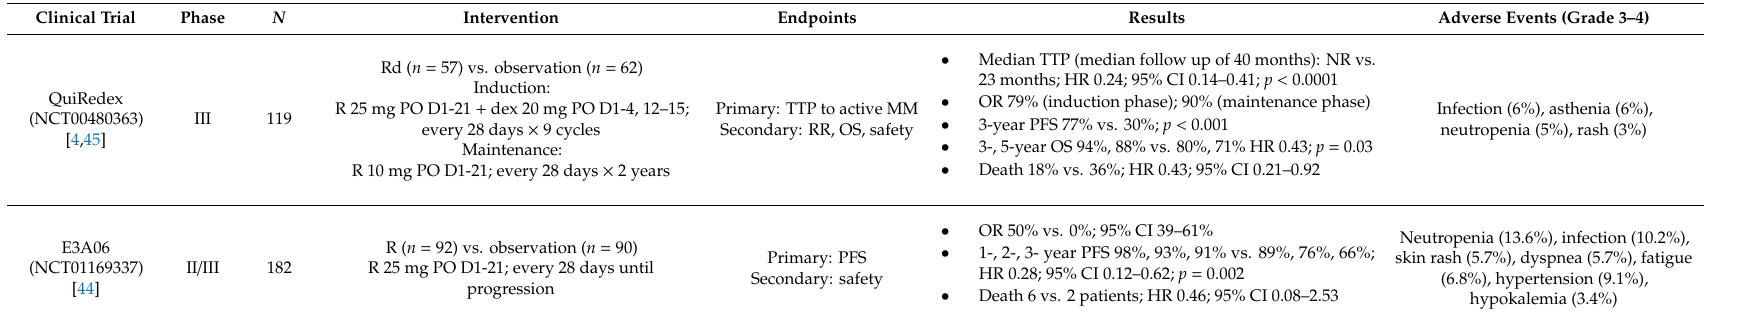
Table 3. Summary results of clinical trials investigating early intervention as a prevention strategy in SMM.